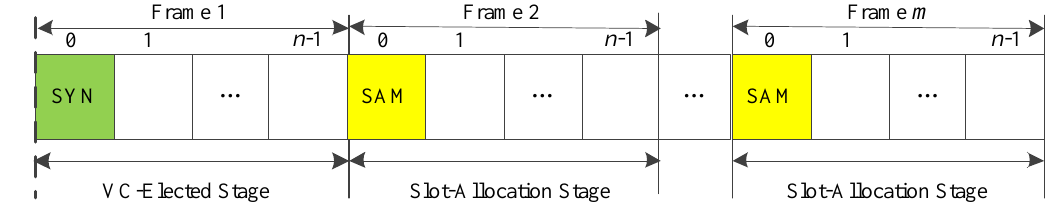
Figure 5. Time structure of CBT.